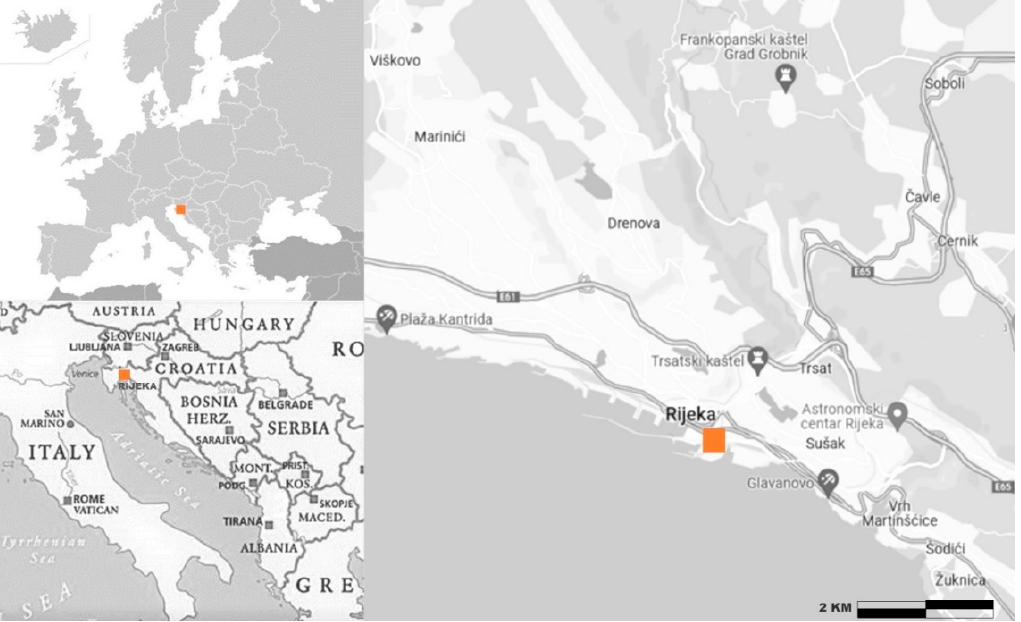
Figure 3. Upper left corner—the position of City of Rijeka regarding European and Asian continents, lower left corner—the position of City of Rijeka with regards to Republic of Croatia and neighboring countries, right—the position of Delta area in City of Rijeka.